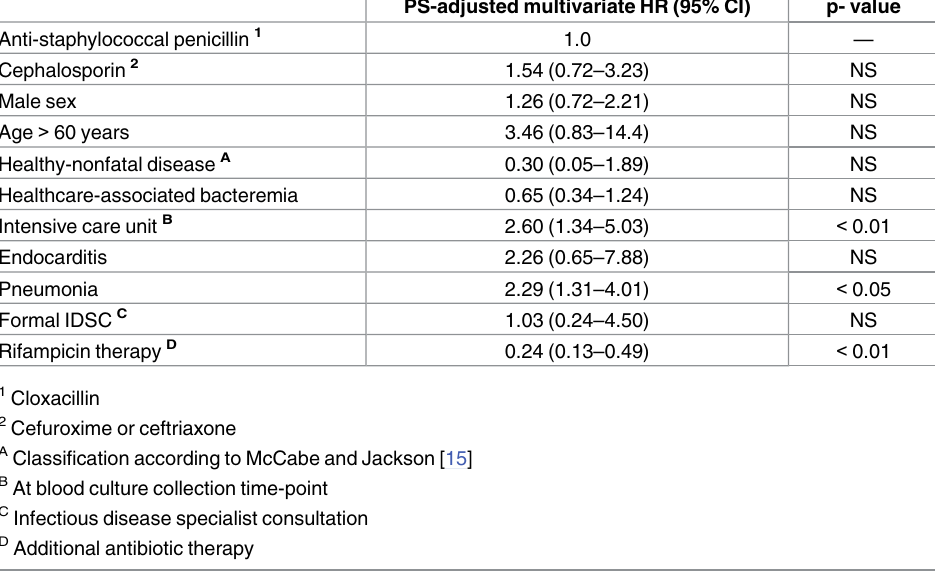
Table 3. Propensity-score adjusted Cox proportional regression analysis for 28-days mortality among 580 patients with methicillin-sensitive Staphylococcus aureus bacteremia receiving either anti-staphylococcal penicillin (n = 92) or cephalosporin (n = 488) as first week antimicrobial treatment.